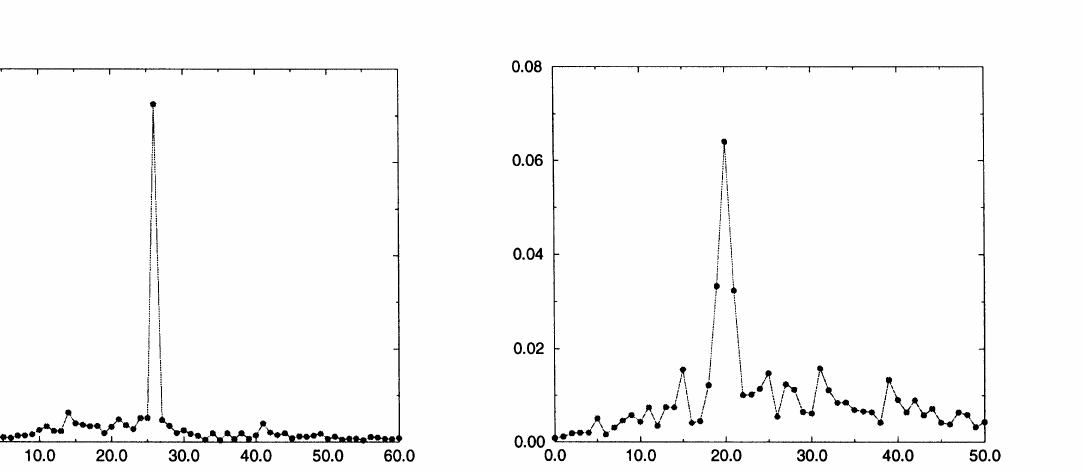
FIGURE 3 The velocity correlation function for the case vL =0.8.